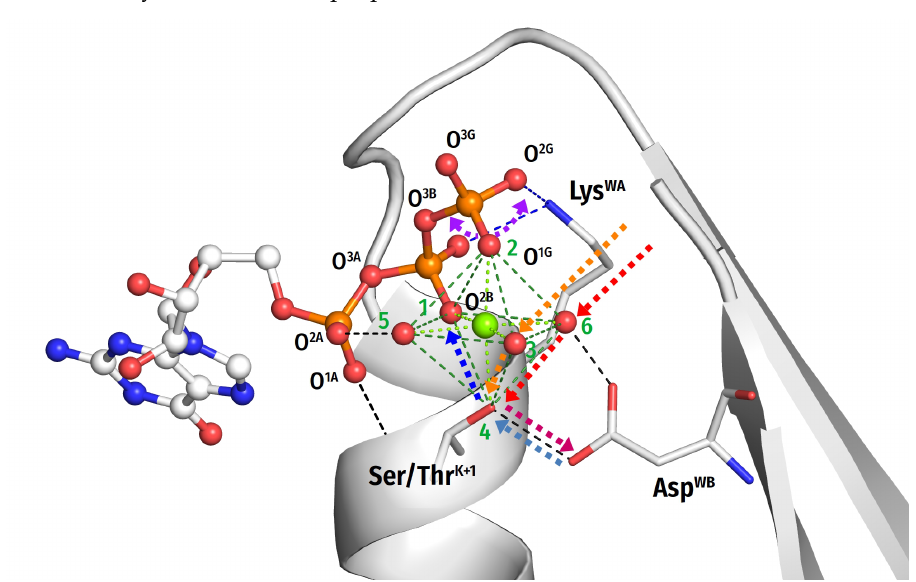
Figure 10. Schematic presentation of tentative proton routes along the edges of the octahedral coordination shell of Mg 2+ ion . The Mg 2+ ligand #3 is assumed to be a water molecule. Proton entry points via ligand #6 or ligand #3 are shown with red and orange arrows, respectively. Protonic connection between [S/T] K+1 and Asp WB are shown by magenta and light blue arrows, the route from [S/T] K+1 to O 2B of β -phosphate is shown as a dark blue arrow. The movement of the O 1G atom as a result of γ -phosphate twist is shown by purple